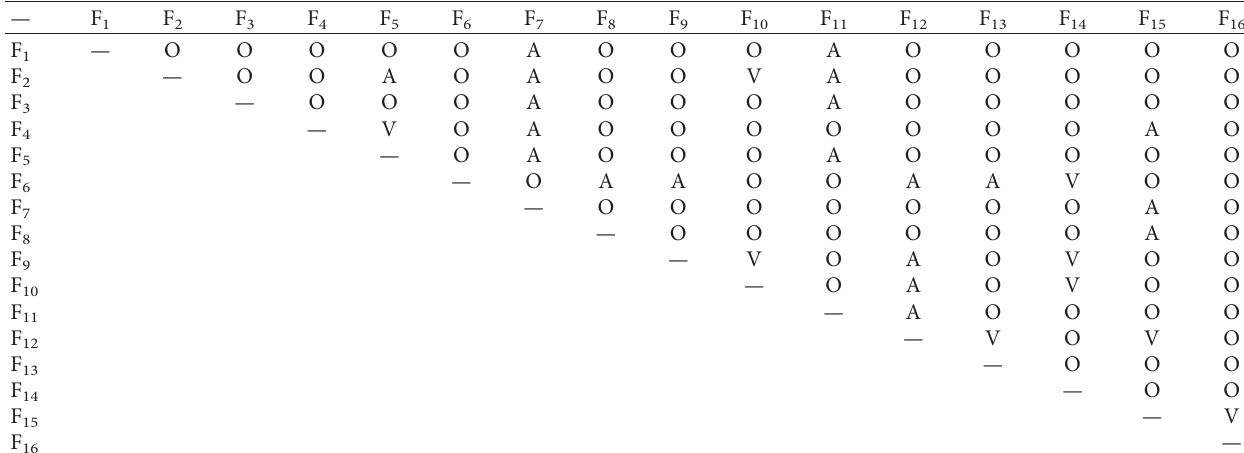
Table 3: Structural